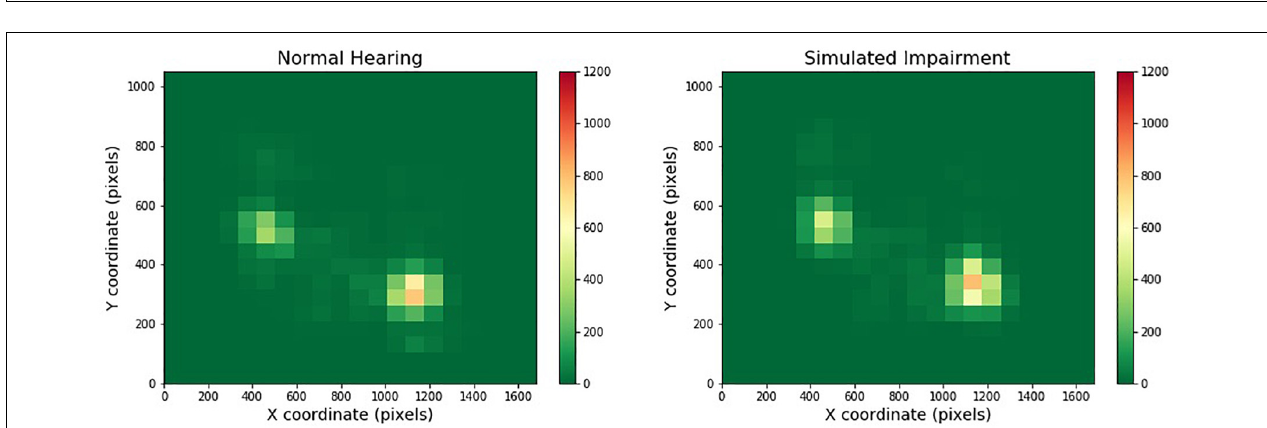
FIGURE 3 | Heatmaps across one- and two-speaker videos and hearing impairment. Regions that are red or yellow indicate greater visual attention, while green regions indicate comparatively lesser visual